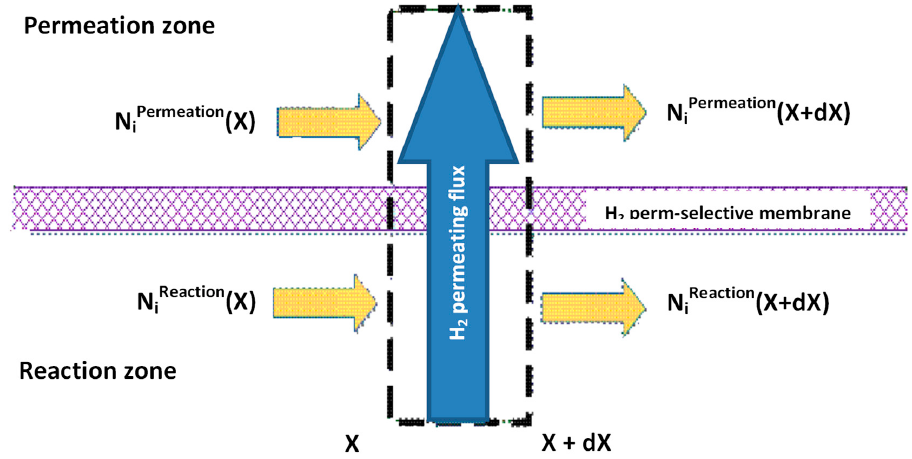
Figure 4. Schematic view of a mass transport in a MR.